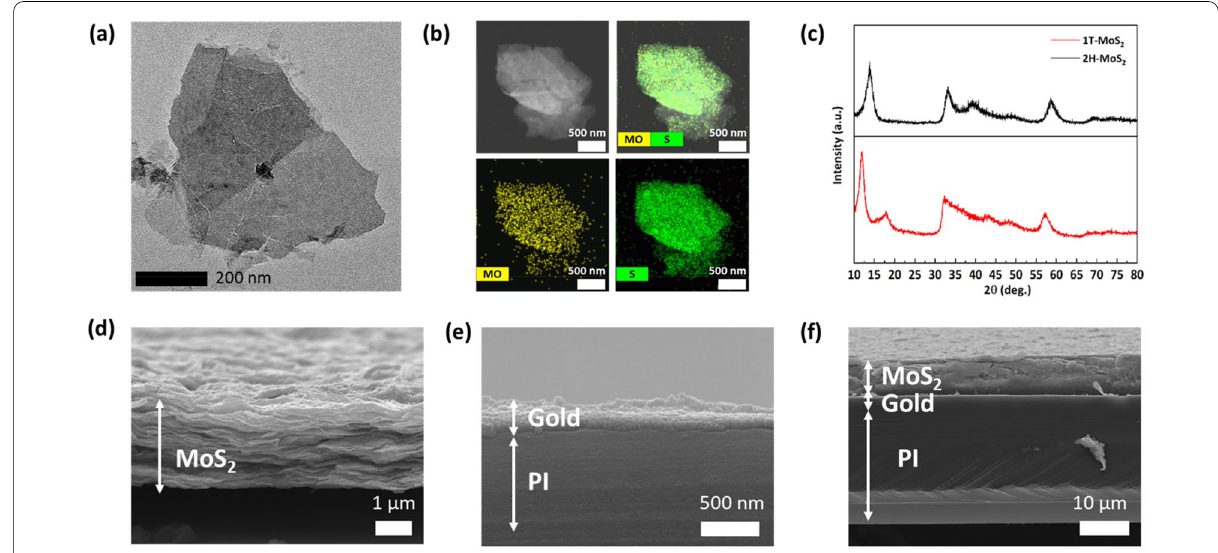
Fig. 2 Fabrication of MoS 2 NSs based actuator. a TEM image and b EDS mapping image of MoS 2 NSs. c XRD pattern analysis of MoS 2 NSs. Cross‑sectional SEM images of d the vacuum filtered MoS 2 NSs, e gold coated PI film and f MoS 2 NS‑modified Au‑coated PI